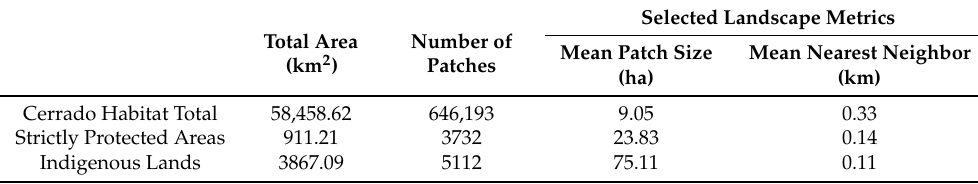
Table 1. Mato Grosso do Sul landscape metrics.